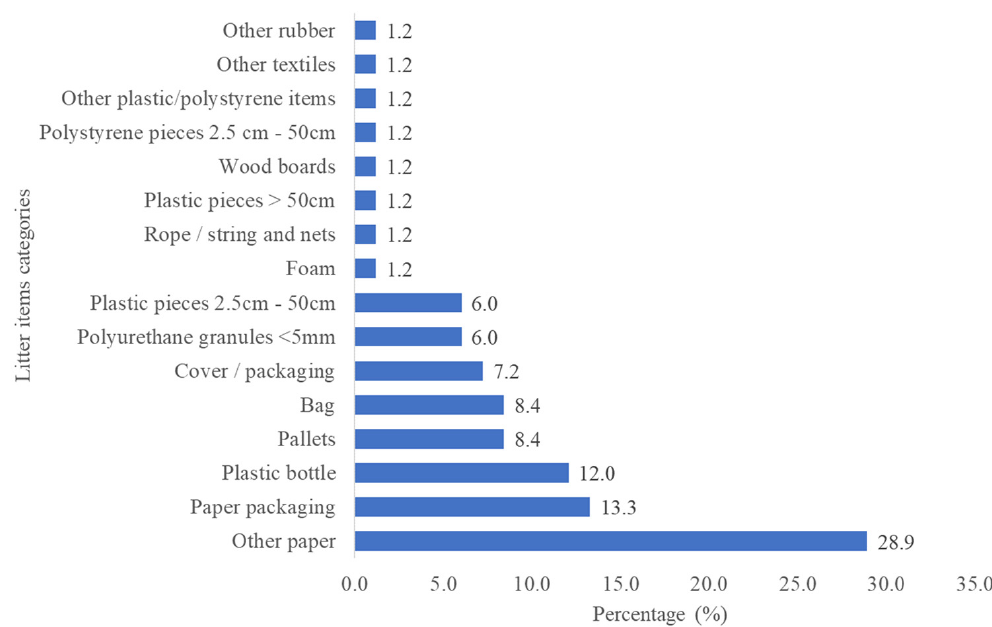
Figure 3. Percentage of recorded litter item categories in the Don River.